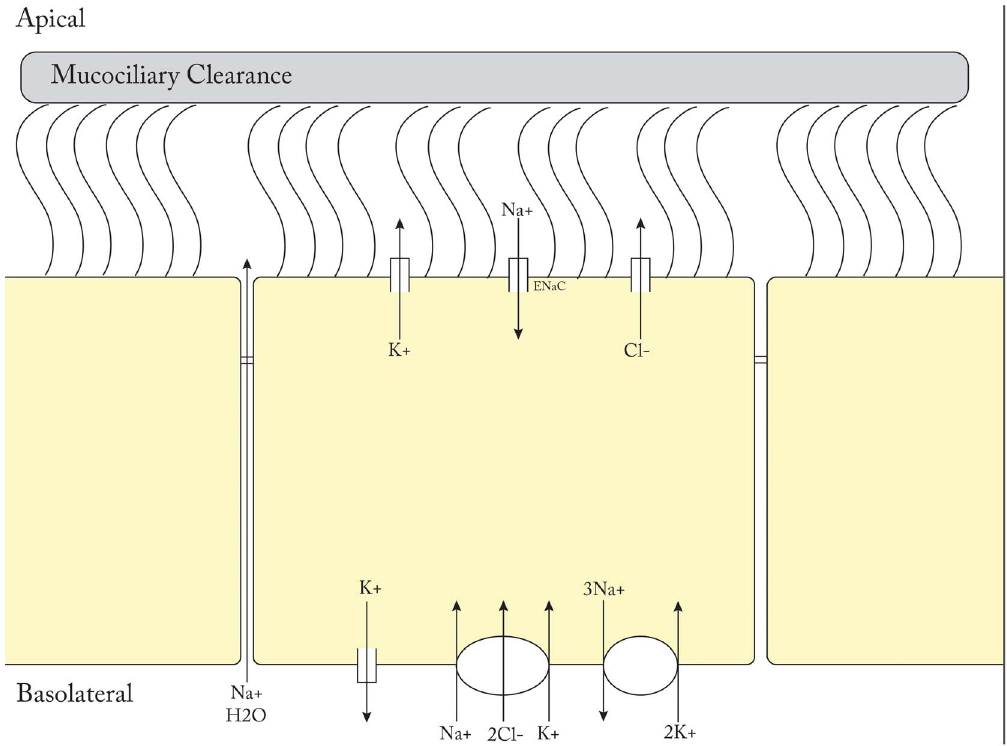
Figure 2. Schematic drawing of ciliated epithelial airway ion transport.